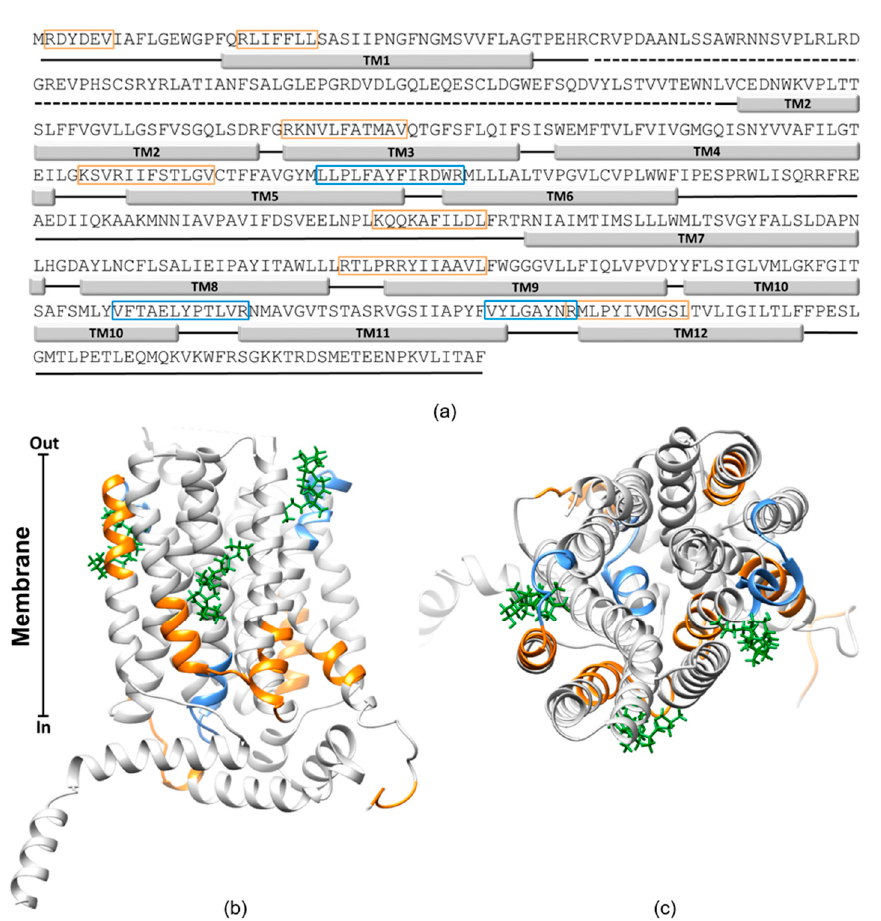
Figure 9. Bioinformatic analysis. ( a ) Primary structure of the human OCTN1 transporter. The transmembrane α -helices (TM1-12) are depicted as light gray rectangles. The region containing the amino acids from 50 to 133 (big extracellular loop, absent in the homology model) is depicted as dotted line. Hypothetical cholesterol-binding motifs CRAC and CARC are indicated as blue and orange boxes, respectively. ( b , c ) side and top view, respectively, of the homology structural model of the OCTN1 docked with three molecules of cholesterol (green). In this ribbon representation, only the best three (lowest binding energy) out of the twenty-two predicted by Achilles blind docking server, are reported.